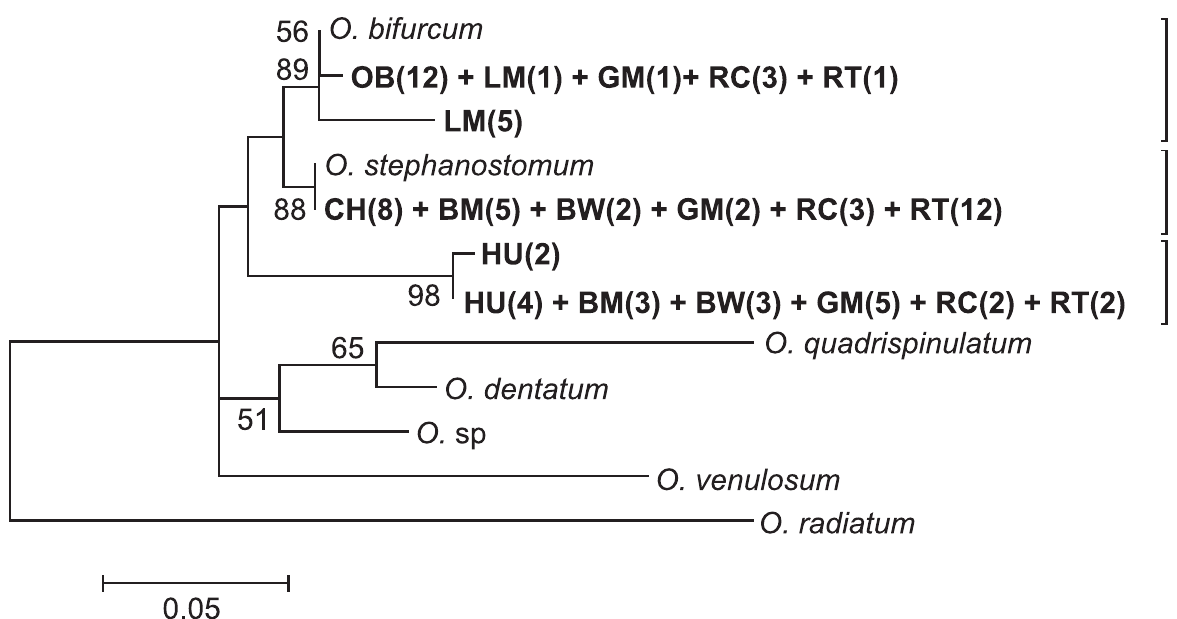
Figure 3. Phylogenetic analysis of Oesophagostomum based on ITS2 rDNA (260 bp) sequences. Nucleotide sequences were aligned using Clustal X software [42]. Phylogenetic relationships were inferred in MEGA5 [44], using the maximum likelihood method with a Hasegawa-Kishino- Yano model of nucleotide substitution [45]. The best-scoring maximum-likelihood tree is shown here ( 2 lnL=656.5). Bootstrap values (%) greater than 50% are shown. Taxon names of sequences generated in this study are in bold and correspond to the host species followed by the number of infected individuals in parentheses (BM=blue monkey, BW=black and white colobus, CH=chimpanzee, LM=l’hoest monkey, GM=grey-cheeked mangabey, OB=olive baboon, RC=red colobus, RT=red-tailed guenon, and HU=human). Reference sequences correspond to Genbank accession numbers AF136575 and Y11733 for O. bifurcum , AF136576 for O. stephanostomum , HQ844232 for O. sp , Y11738 for O. quadrispinulatum , Y11735 for O. dentatum , Y10790 for O. venulosum , and AJ006149 for O. radiatum . Scale bar indicates nucleotide substitutions per